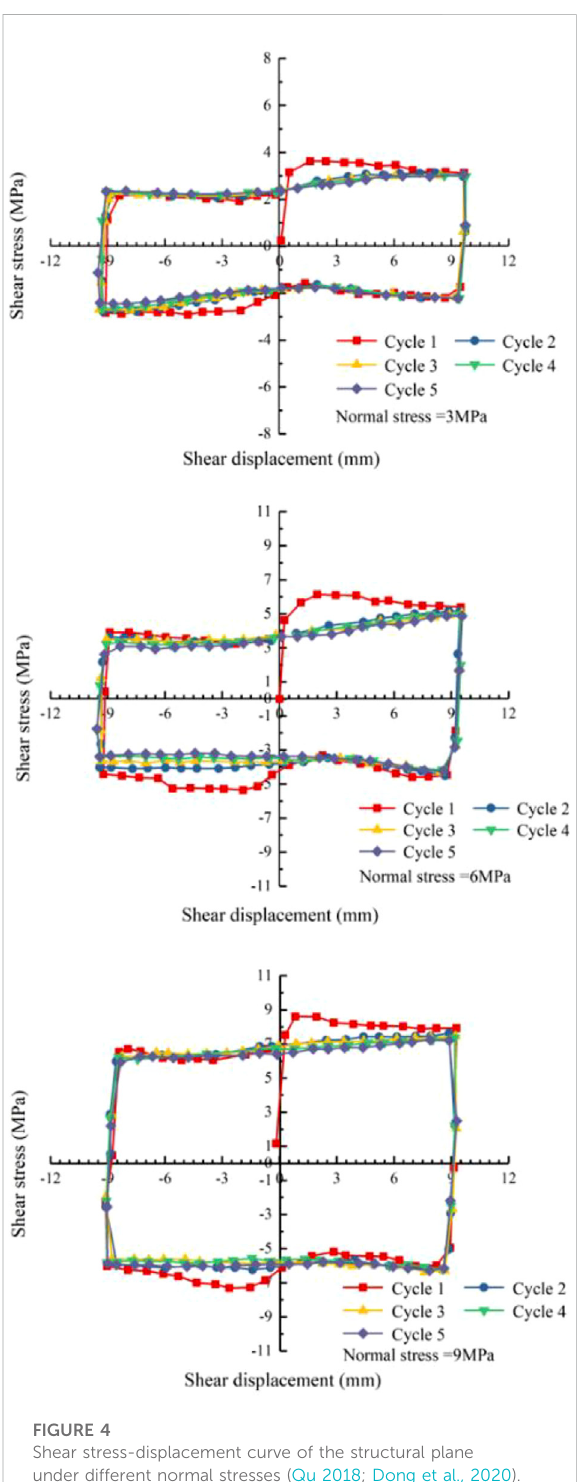
FIGURE 4 Shear stress-displacement curve of the structural plane under different normal stresses (Qu 2018; Dong et al., 2020). where σ n is the effective normal stress, i is the average angle of deviation of particle displacements from the direction of the applied shearstress,and φ istheangleoffrictional slidingresistancebetween b